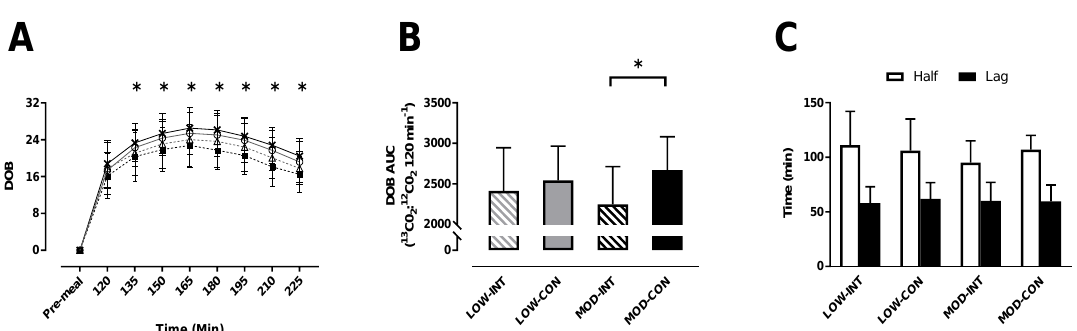
Figure 2. ( A ) Delta over baseline, ( B ) delta over baseline area under curve (AUC), ( C ) half emptying time (T 1/2 ) and time of maximum emptying rate (T lag ). On delta over baseline (DOB) the trials are indicated as; LOW-INT ( ▲ ) , LOW-CON ( ○ ), MOD-INT ( ■ ) and MOD-CON (x). Solid lines represent continuous trials and hashed lines represent intermittent trials. Data points are means with vertical error bars representing SDs. DOB-AUC bar charts represent mean AUC response (0–120 min) to a standardised meal, with vertical error bars representing SDs. T 1/2 and T lag data points are means with vertical error bars representing SDs. Unfilled rectangle indicates T 1/2 ; black rectangle indicates T lag ( n = 12). * Indicates MOD-INT values are significantly different than MOD-CON, determined by Bonferroni adjusted paired t -test ( p < 0.05).